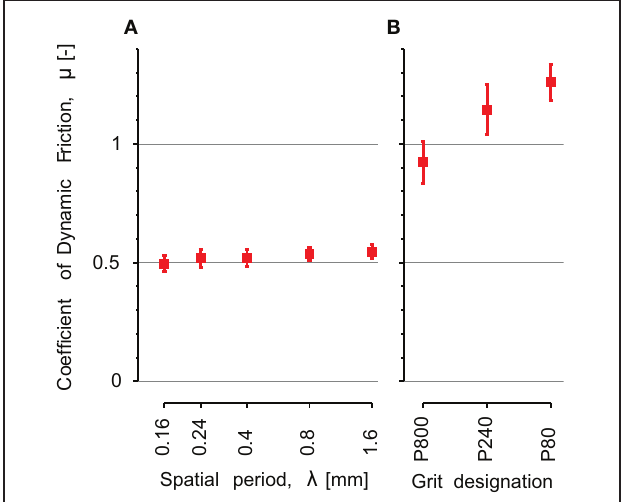
FIGURE 8 | Comparison of coefficient of dynamic friction on the different explored surfaces. (A) Periodic gratings: λ is the spatial period of the periodic stimulus. The x-axis has a logarithmic scale. (B) Sandpapers: from smooth (P800) on the left to rough (P80) on the right. Error bars indicate the standard error of the